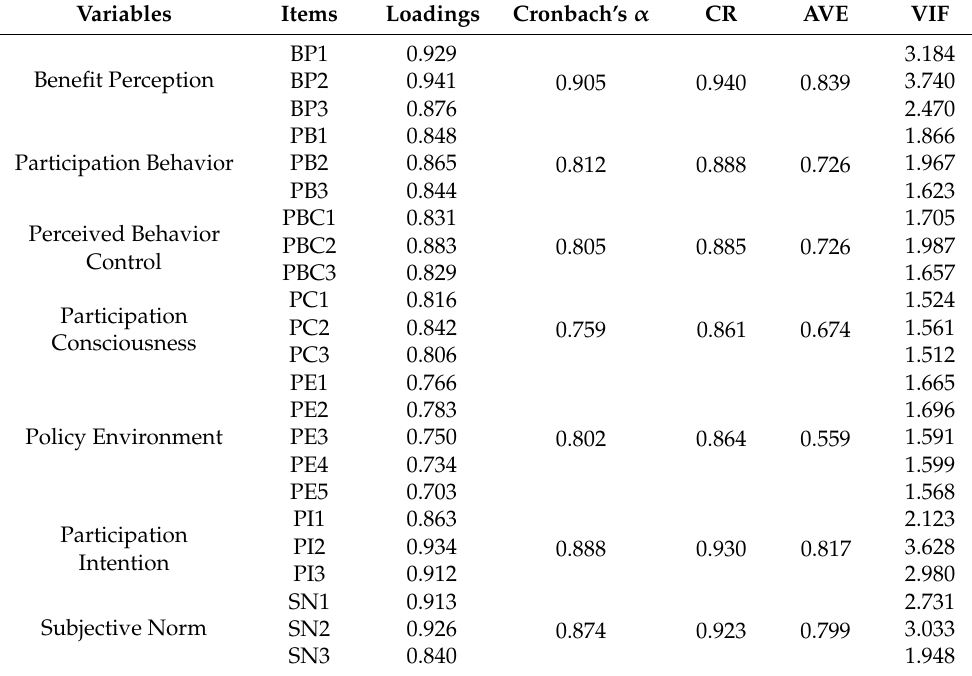
Table 3. Reliability and validity.